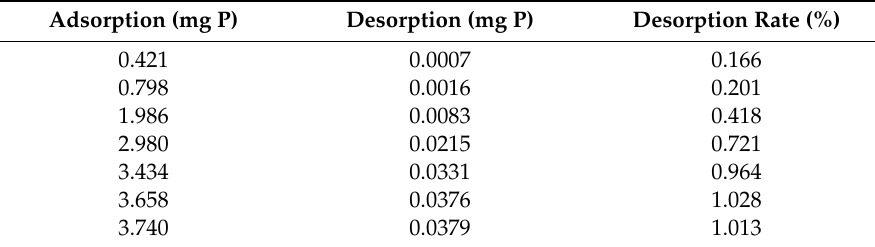
Table 7. Desorption of ZSFB composite fiber in hot water.